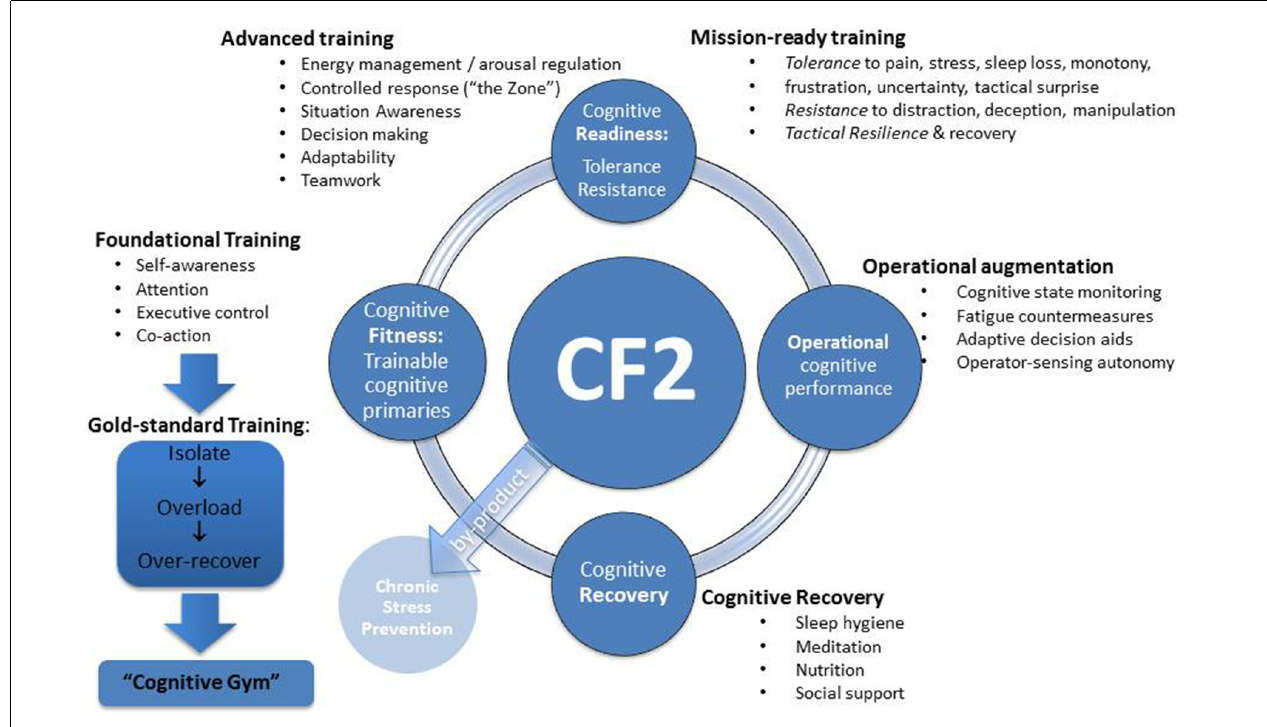
FIGURE 1 | Cognitive fitness framework